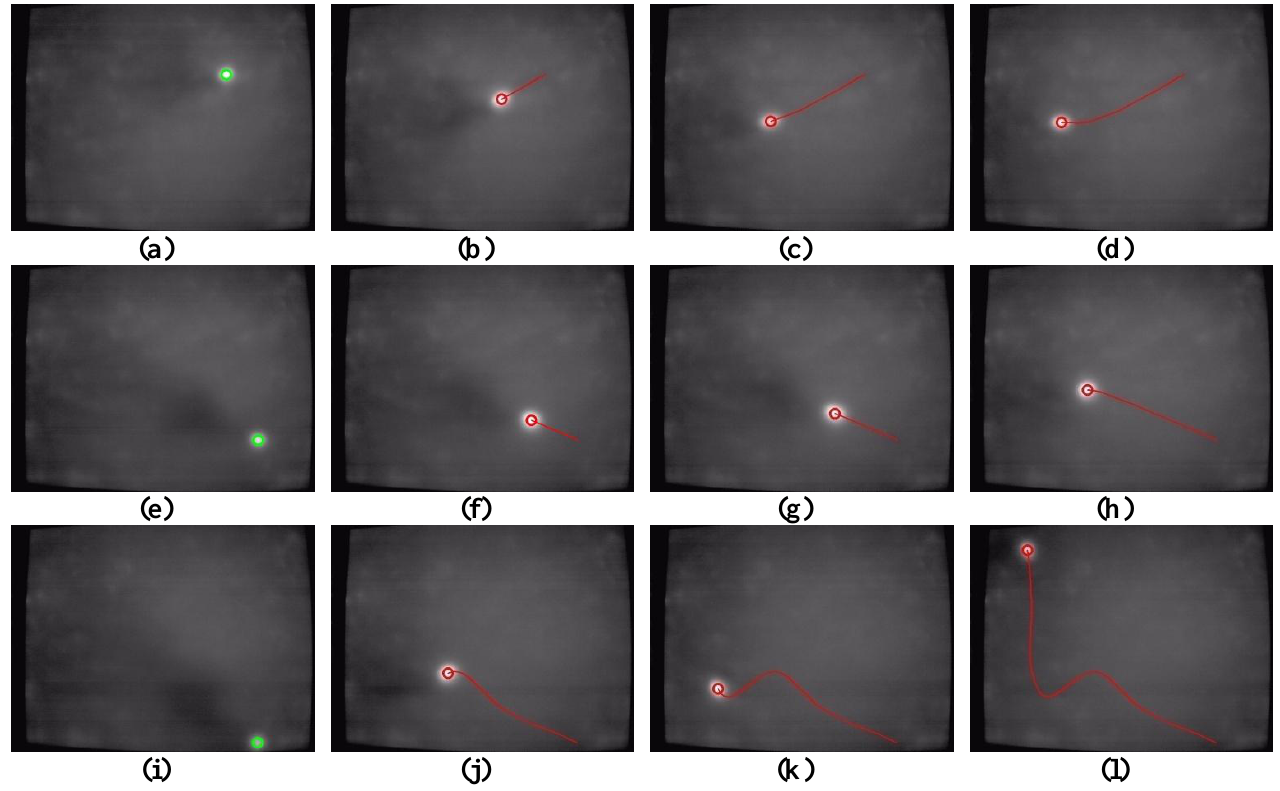
Figure 11. Touch finger detection and tracking results of the proposed system in Test sequence 1. (a) 19 th frame. (b) 26 th frame. (c) 30 th frame. (d) 33 rd frame. (e) 226 th frame. (f) 233 rd frame. (g) 235 th frame. (h) 243 rd frame. (i) 676 th frame. (j) 696 th frame. (k) 706 th frame. (l) 725 th frame.